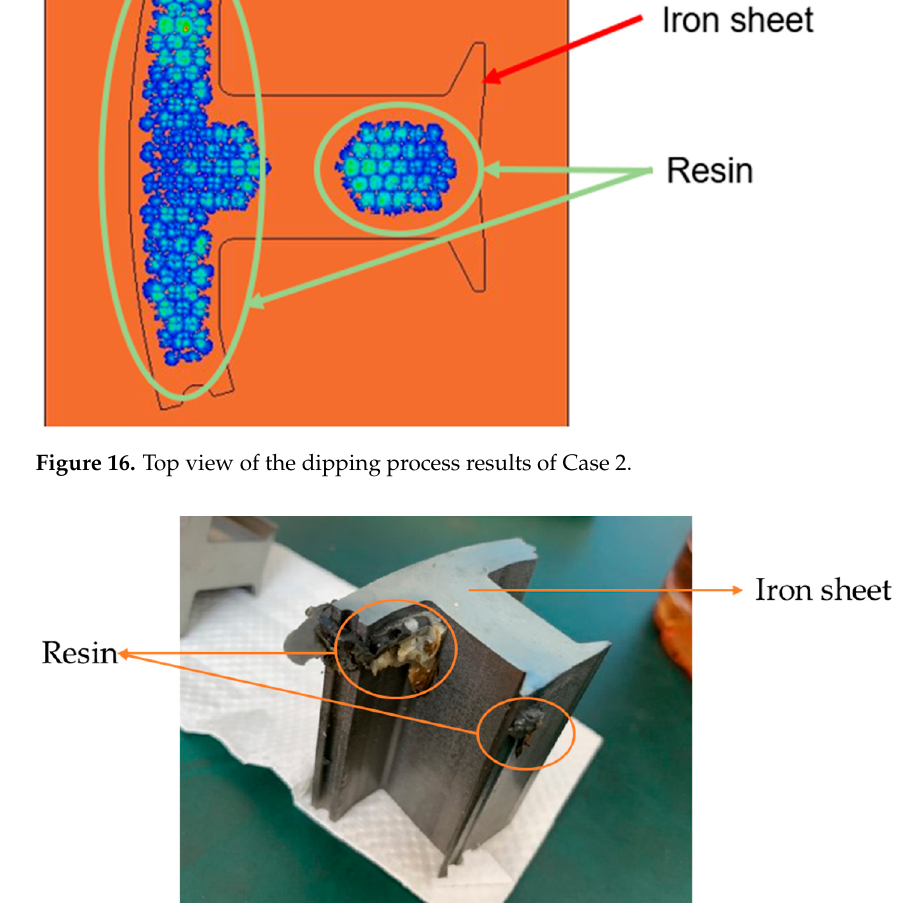
Figure 17. Schematic diagram of bumps caused by resin over-flow.